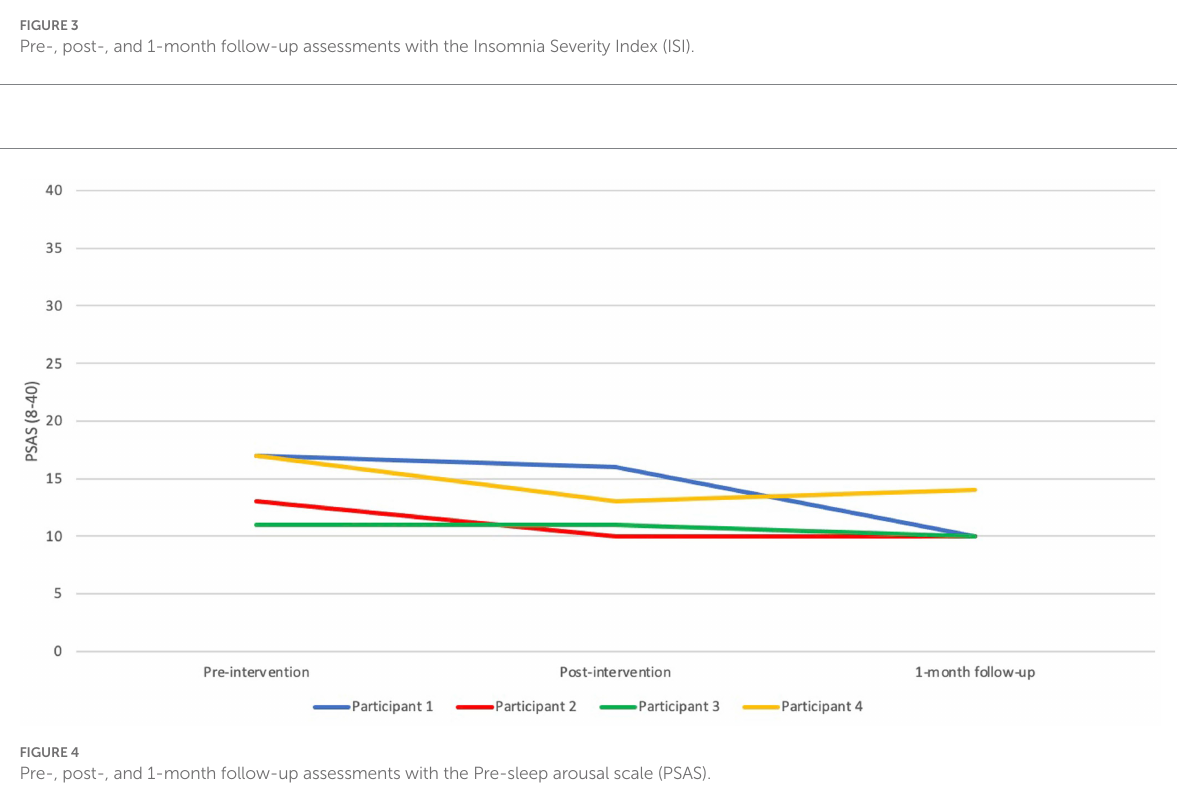
FIGURE 3 Pre-, post-, and 1-month follow-up assessments with the Insomnia Severity Index (ISI).